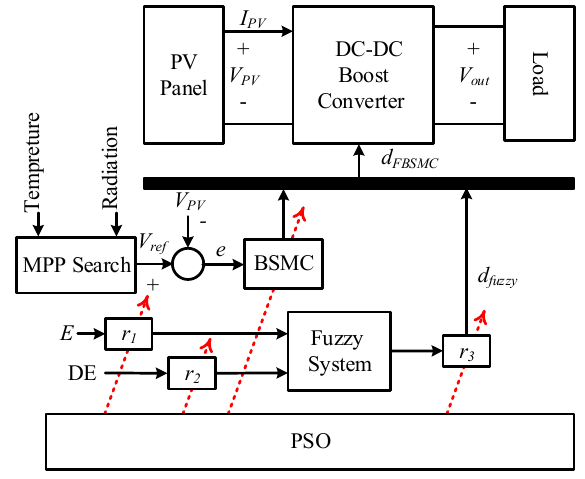
Figure 3. Configuration of a PV system with the proposed controller. Table 2. Rules of the Fuzzy System.